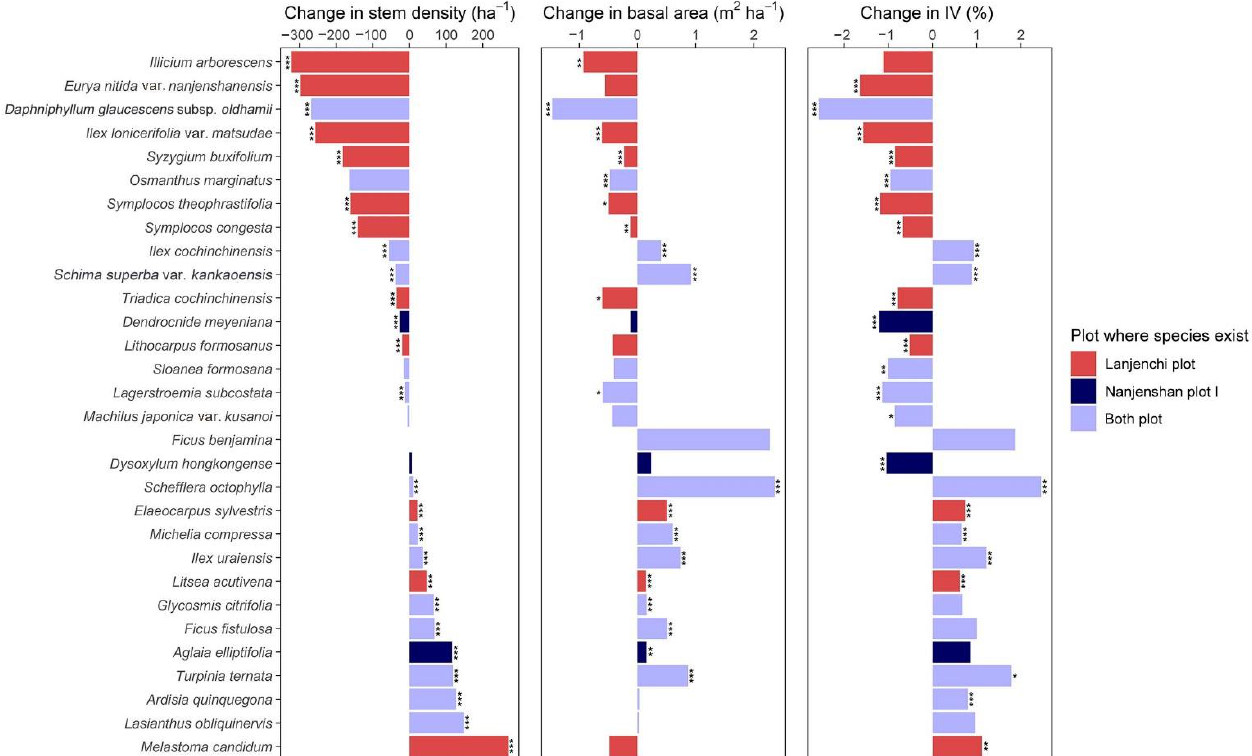
Figure 3. Changes in stem density, basal area, and importance value of 30 species having the greatest increases and decreases by importance values from census 1 to census 5. Red bar indicates the species that only exist in the high wind exposure forest (Lanjenchi plot), the dark blue bar indicates the species that only exist in the low wind exposure forest (Nanjenshan plot I), and light purple bar indicates species that existing in both forests. *, **, and *** beside the bar representing the significant difference under the generalized estimating equations of α < 0.05, α < 0.01, α < 0.001, respectively from the preceding census.